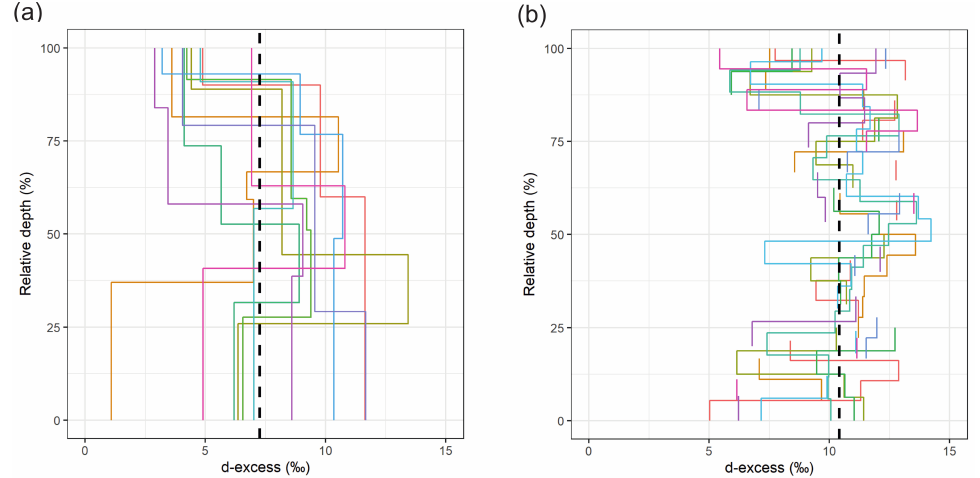
Figure 8. Snow layer d-excess as a function of relative depth for ( a ) Imnavait and ( b ) Pallas. Dashed lines indicate the mean d-excess value for all samples.